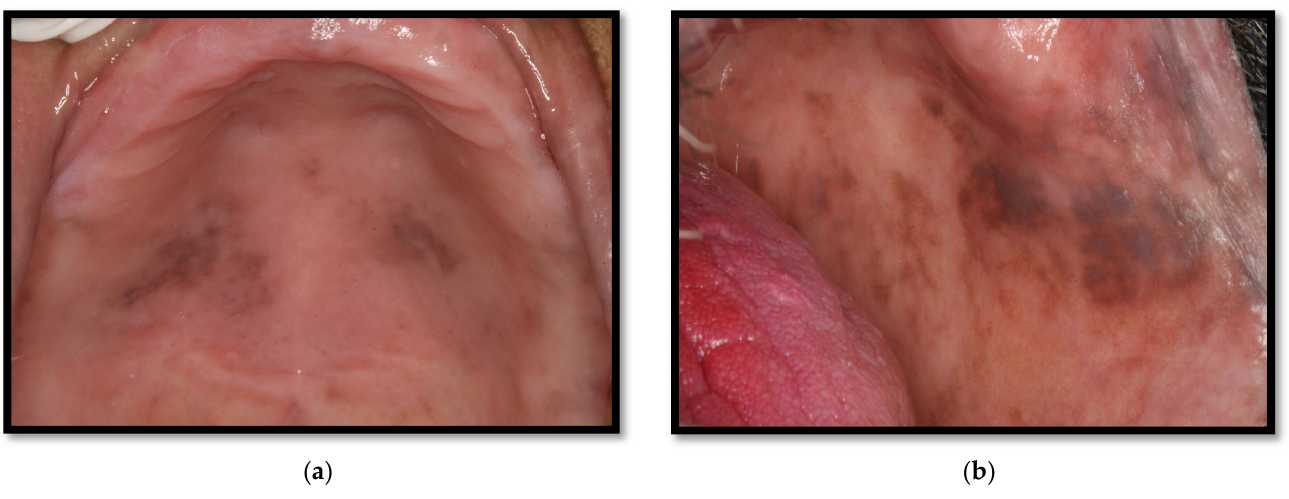
( b ) Figure 11. ( a ) Oral hairy leukoplakia on the underside of the tongue; ( b ) Oral hairy leukoplakia on the lateral border of the tongue. 8. Oral Hyperpigmentation Oral hyperpigmentation appears in up to 37% of patients who have a CD4 + T lym- phocyte count of <100 cells/ μ L. The causes of this condition remain unknown, though it has been associated with ART, particularly zidovudine, a thymidine analog reverse tran- scriptase inhibitor. Other drugs, such as clofazimine and ketoconazole, have also been associated, among others [16,45]. Oral hyperpigmentation manifests as black or maroon papules, associated with intraleukocytic melanin or pigments within the basal cell mem- brane or lamina propria, with premature melanosomes. It can show up anywhere on oral mucosal membranes [16,46] (Figure 12a,b). According to reports, HIV-positive patients